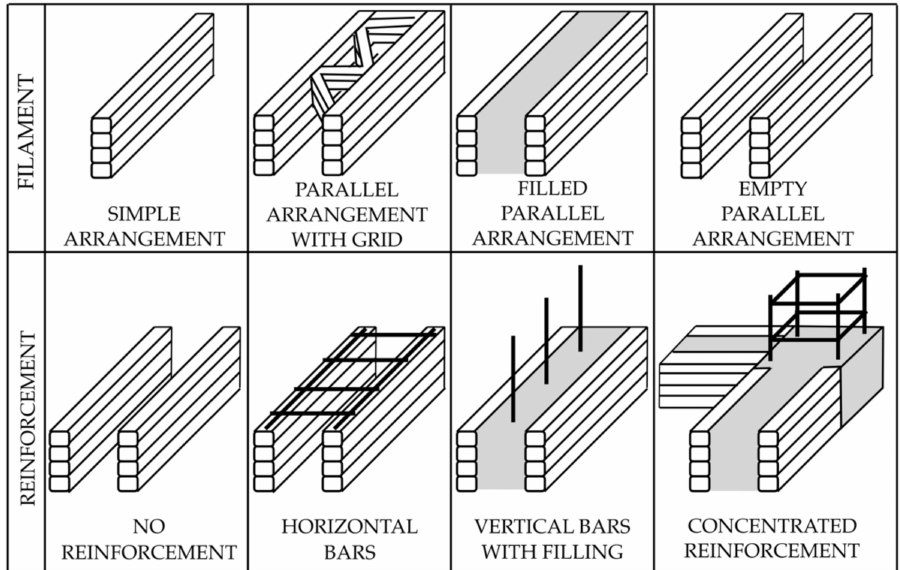
Figure 8. Types of walls ( upper file ) and types of reinforcement ( bottom file ) in the 3D-printed constructions